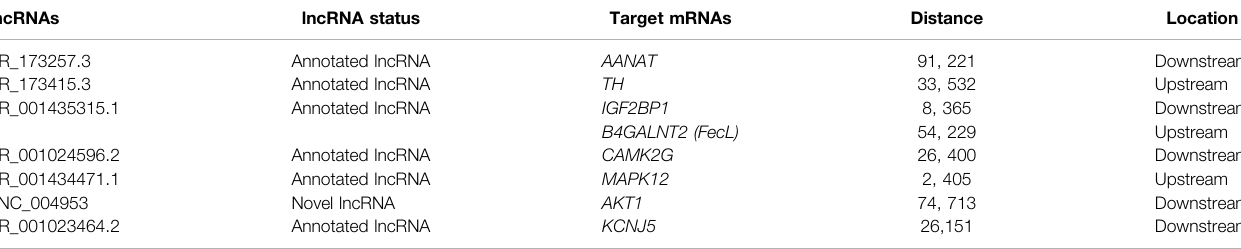
TABLE 5 | Genomic association between lncRNAs and nearby genes related to photoperiodic responsiveness and ovine estrous